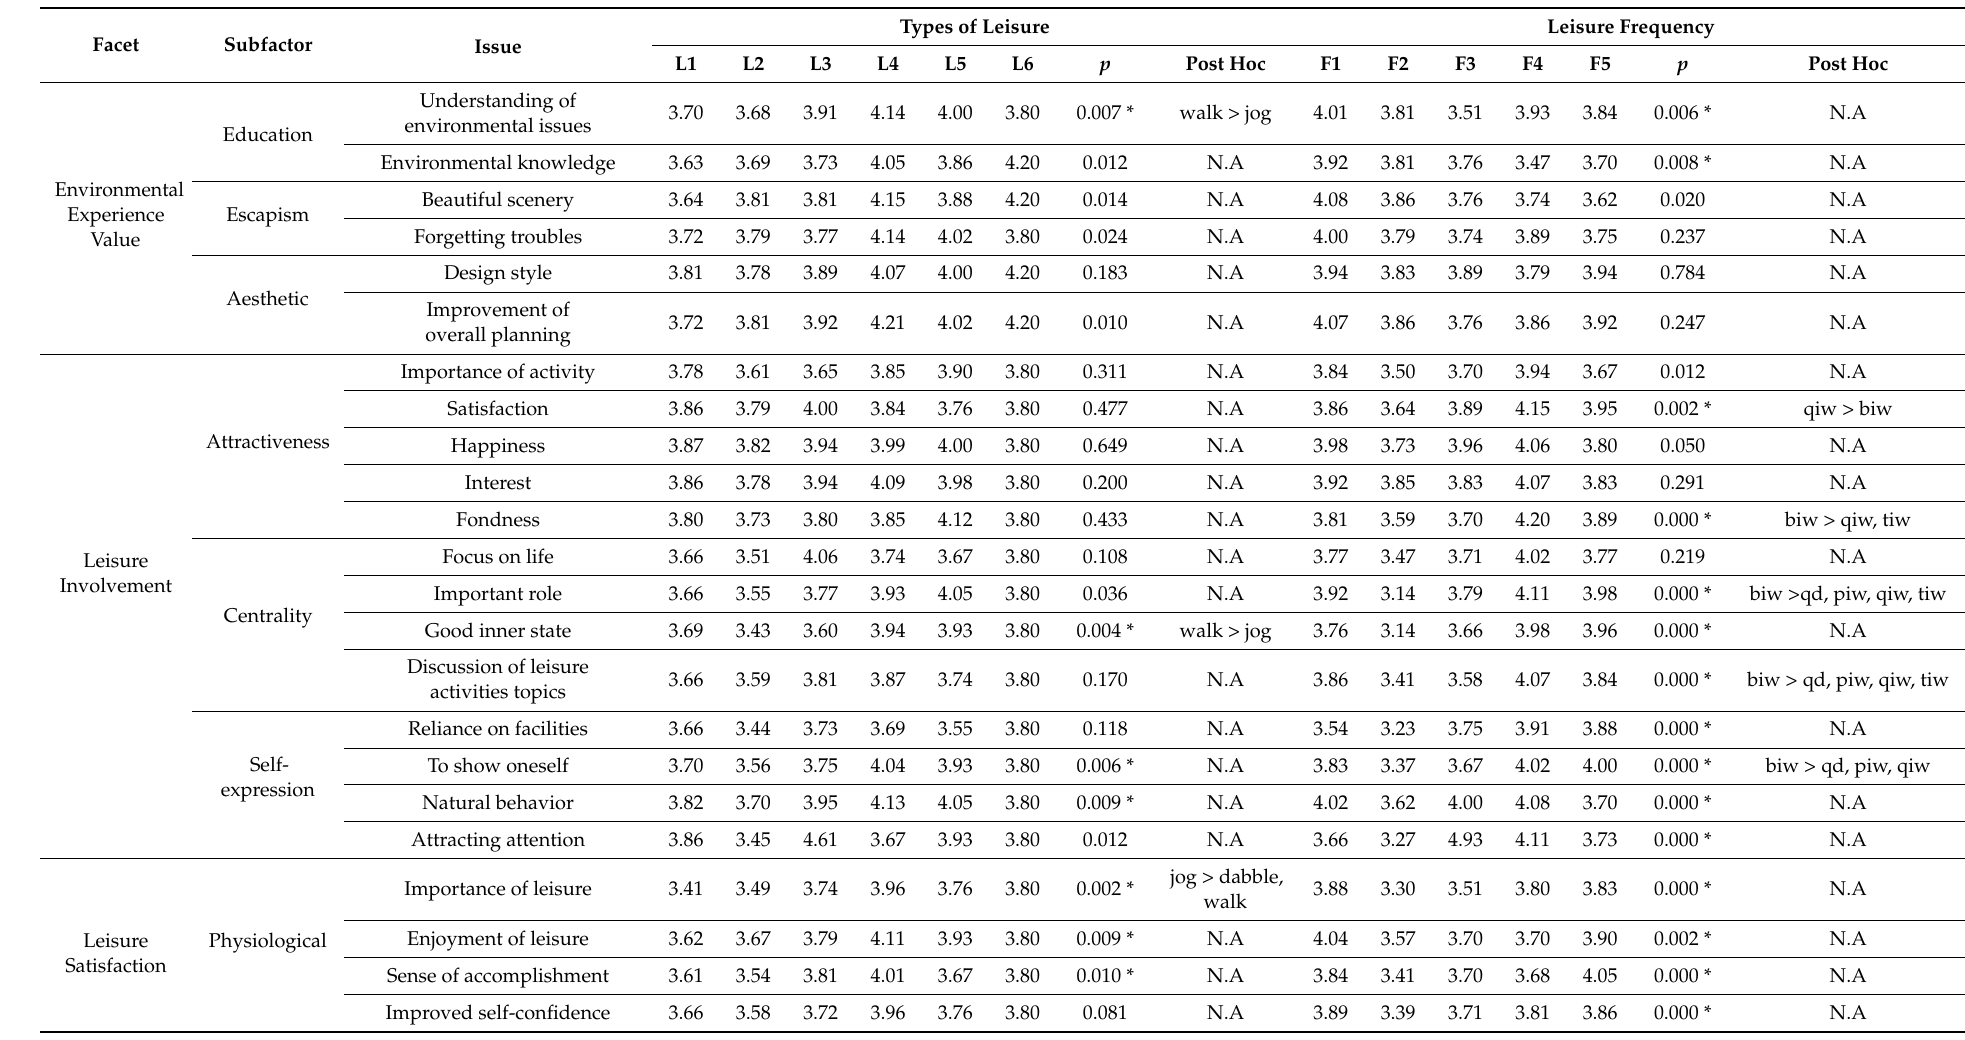
Table 3. Analysis of cognitive differences in environmental experience value, leisure involvement, leisure satisfaction, and well-being (leisure satisfaction and